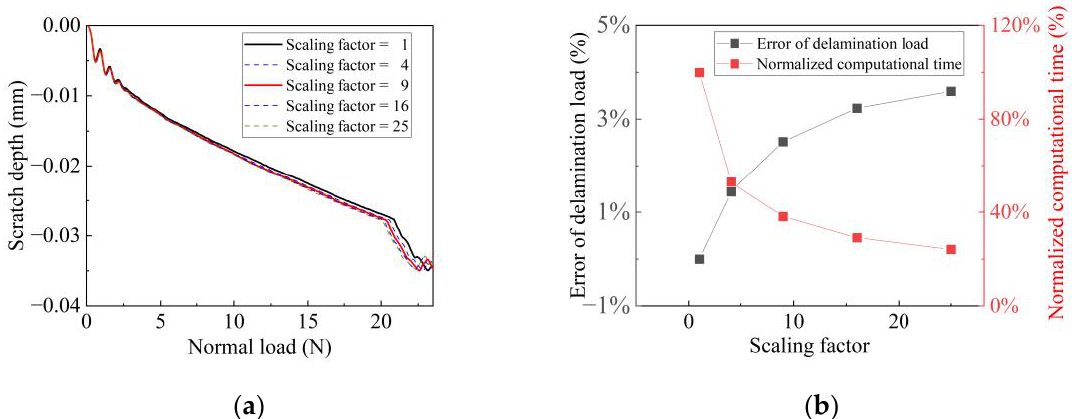
Figure 3. ( a ) Effect of mass scaling factors on scratch depth; ( b ) Errors in delamination load and reduction in computational cost with scaling factors.